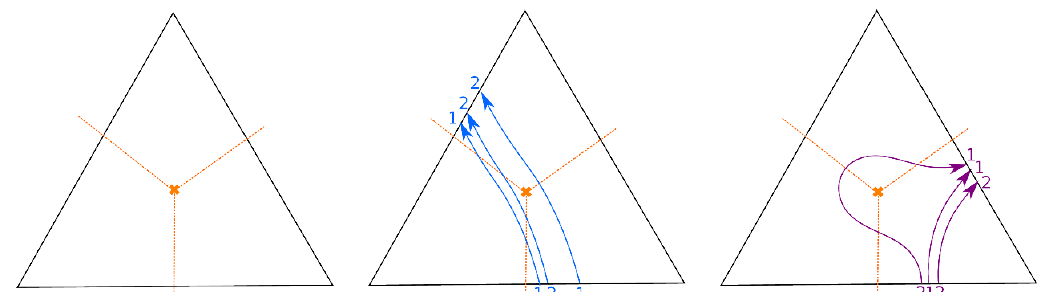
Figure 4. Left: a triangle with branch point and branch cuts marked. Middle: lifted left-turn paths. Right: lifted right-turn